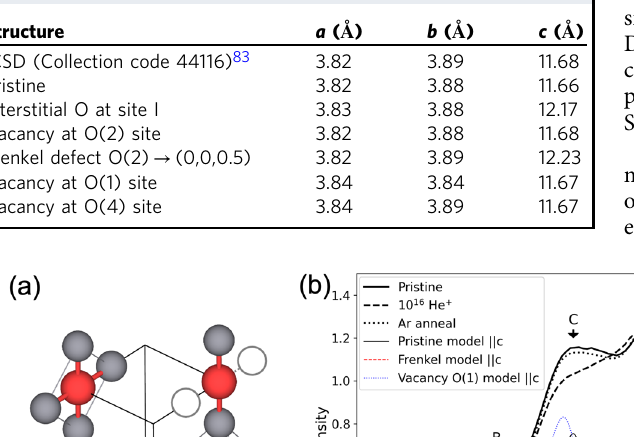
Table 2 Lattice parameters for various oxygen defect structures calculated by geometry optimisation of the unit cell.